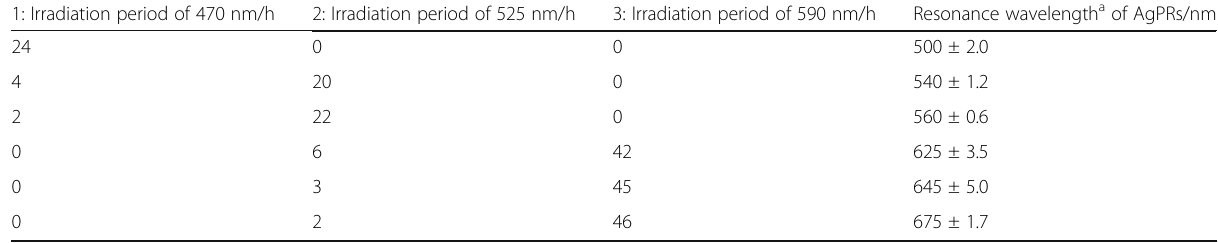
Table 1 Synthetic conditions for AgPRs with various resonance